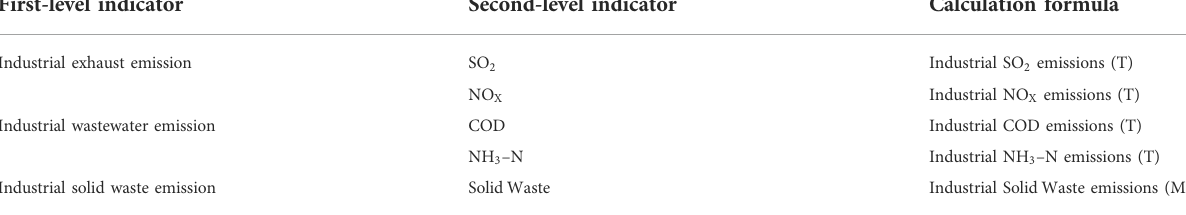
TABLE 2 Evaluation system of industrial pollution emission